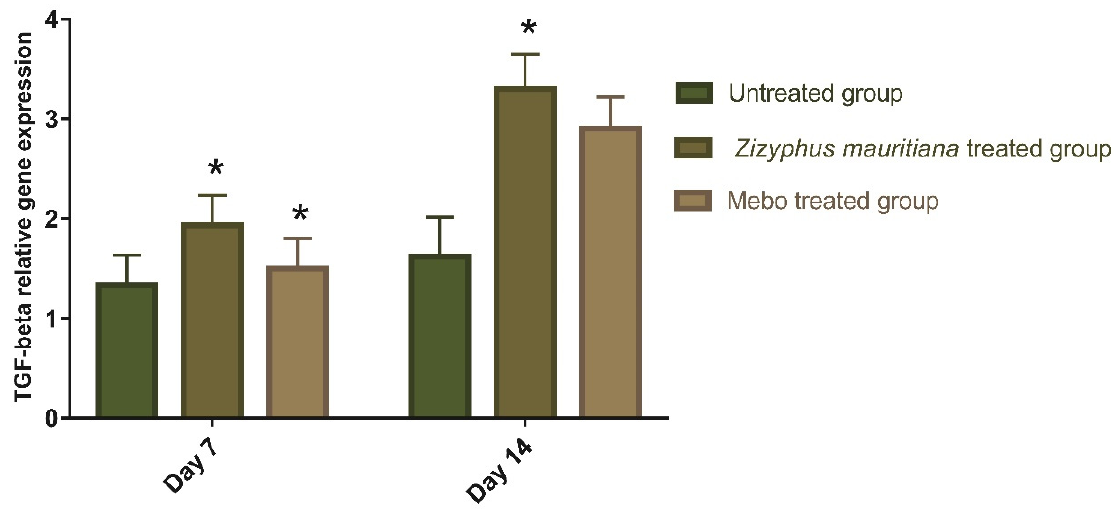
Figure 5. Gene expression in wound tissues for rabbits of different groups via quantitative RT-PCR. Data represent fold change relative to the normal control group expression after normalization to glyceraldehyde 3-phosphate dehydrogenase (GAPDH). Bars represent mean ± SD. The significant difference between groups analyzed by a two-way ANOVA test, where: * p < 0.001 compared to the untreated group on the respective day.